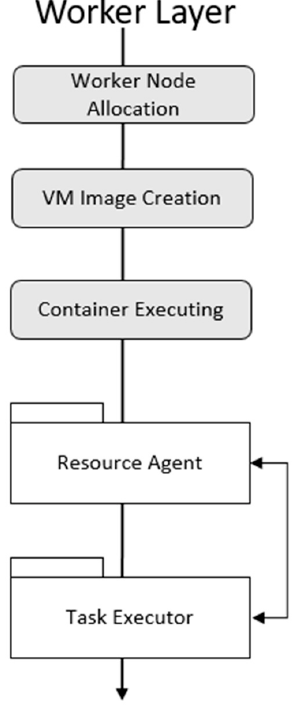
Figure 8. Module operation process on Worker Layer .